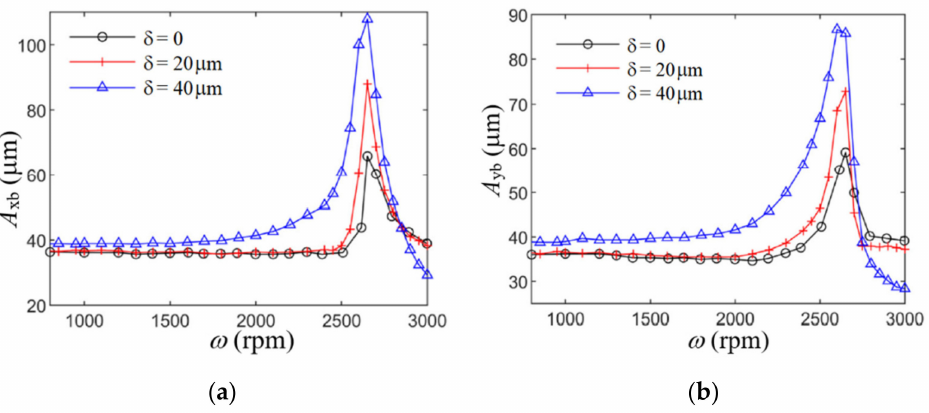
Figure 21. The vibration amplitude for the rod–disk rotor systems within different inner misalign- ments. ( a ) X–direction vibration; ( b ) Y–direction